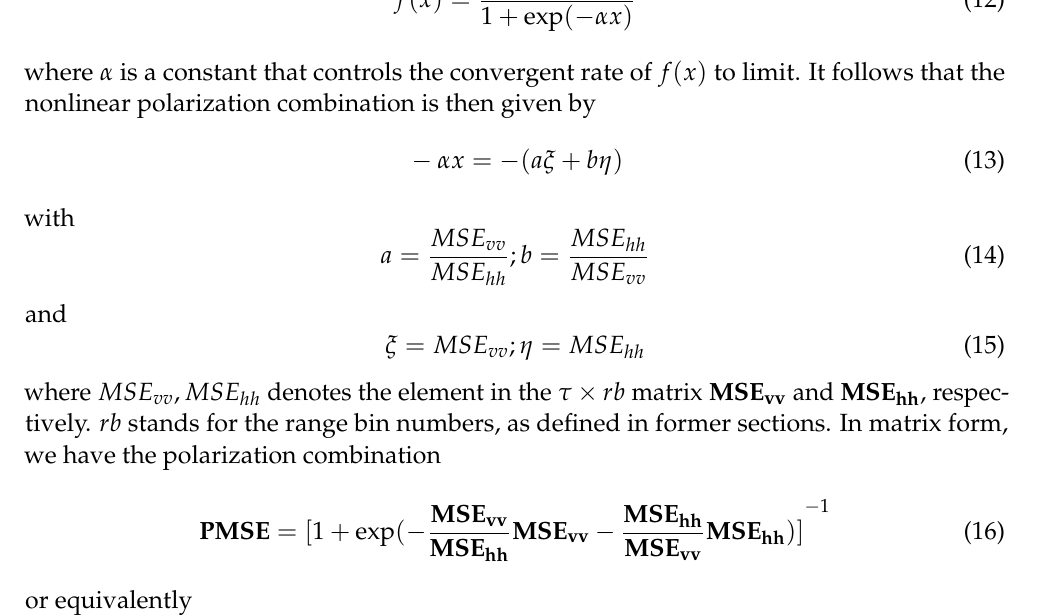
Table 2. MSE ratio ∑